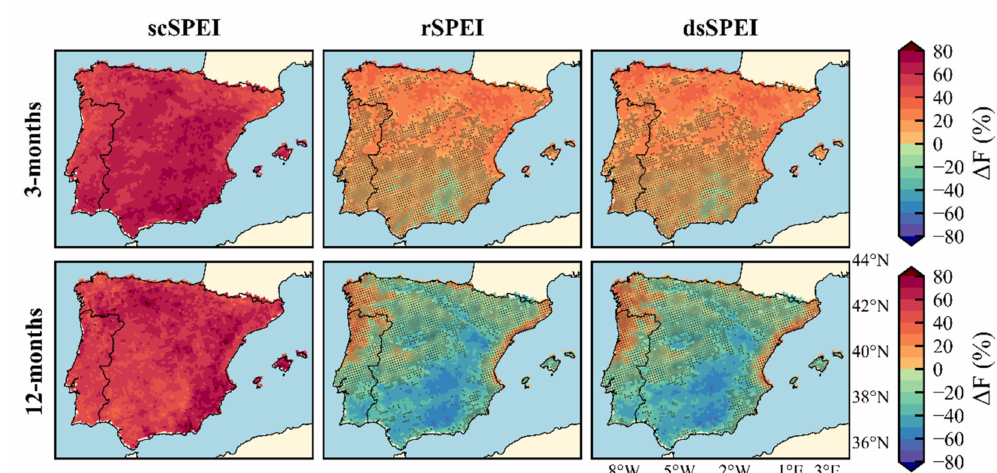
Figure 9. Relative changes in the ensemble mean of the drought frequency ( ∆ F, %) between the far future (2070–2099) and recent past (1980–2009) for the three methods analyzed (scSPEI, rSPEI, and dsSPEI) and at both timescales (3- and 12-month). The dashed areas indicate that less than 12 models agree with the ensemble mean in the sign of the